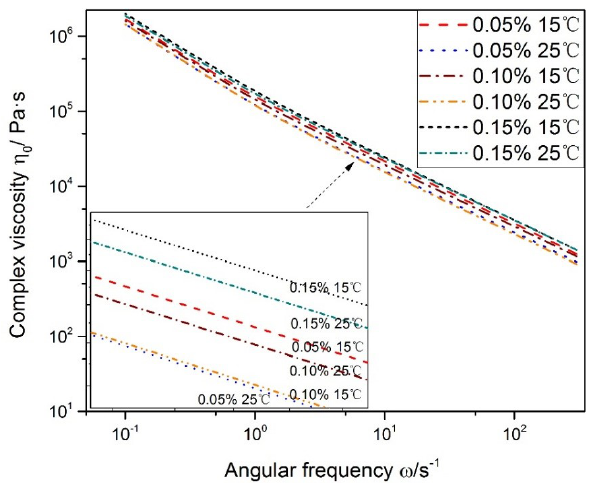
Figure 3: Complex viscosity against angular frequency dependence for graphene of various concentrations at different temperatures (Concentration of solvent in 1